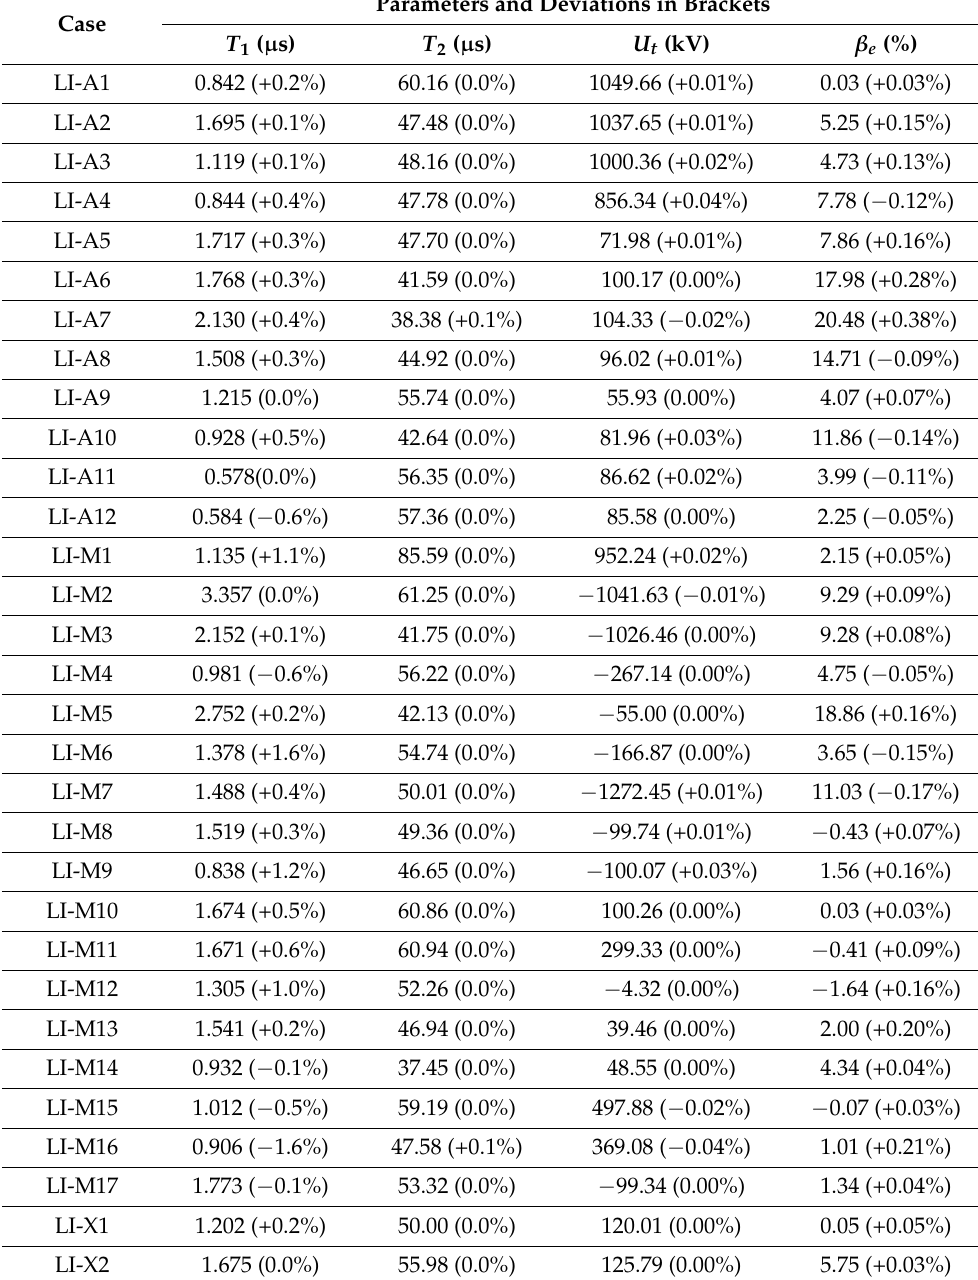
Table 1. The determined waveform parameters using the proposed method and the deviations from the standard recommended values or the values computed using the standard recommended